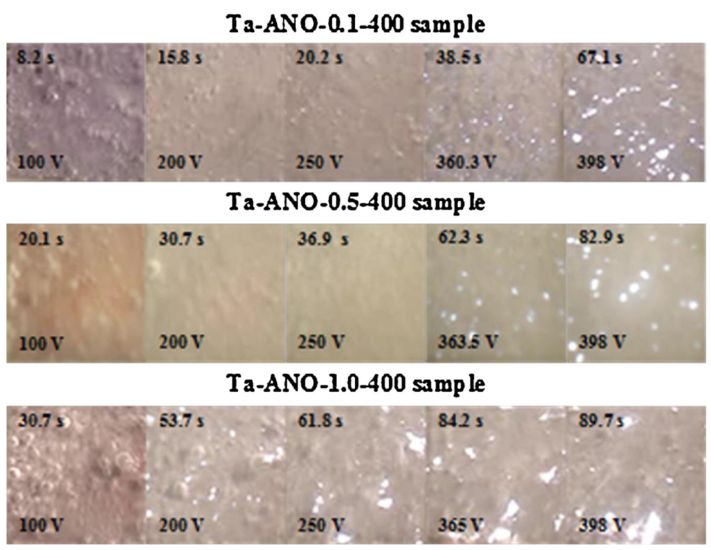
Figure 5. Real-time images of the MAO process of Ta. Reprinted with permission from Ref. [62]. Copyright 2013